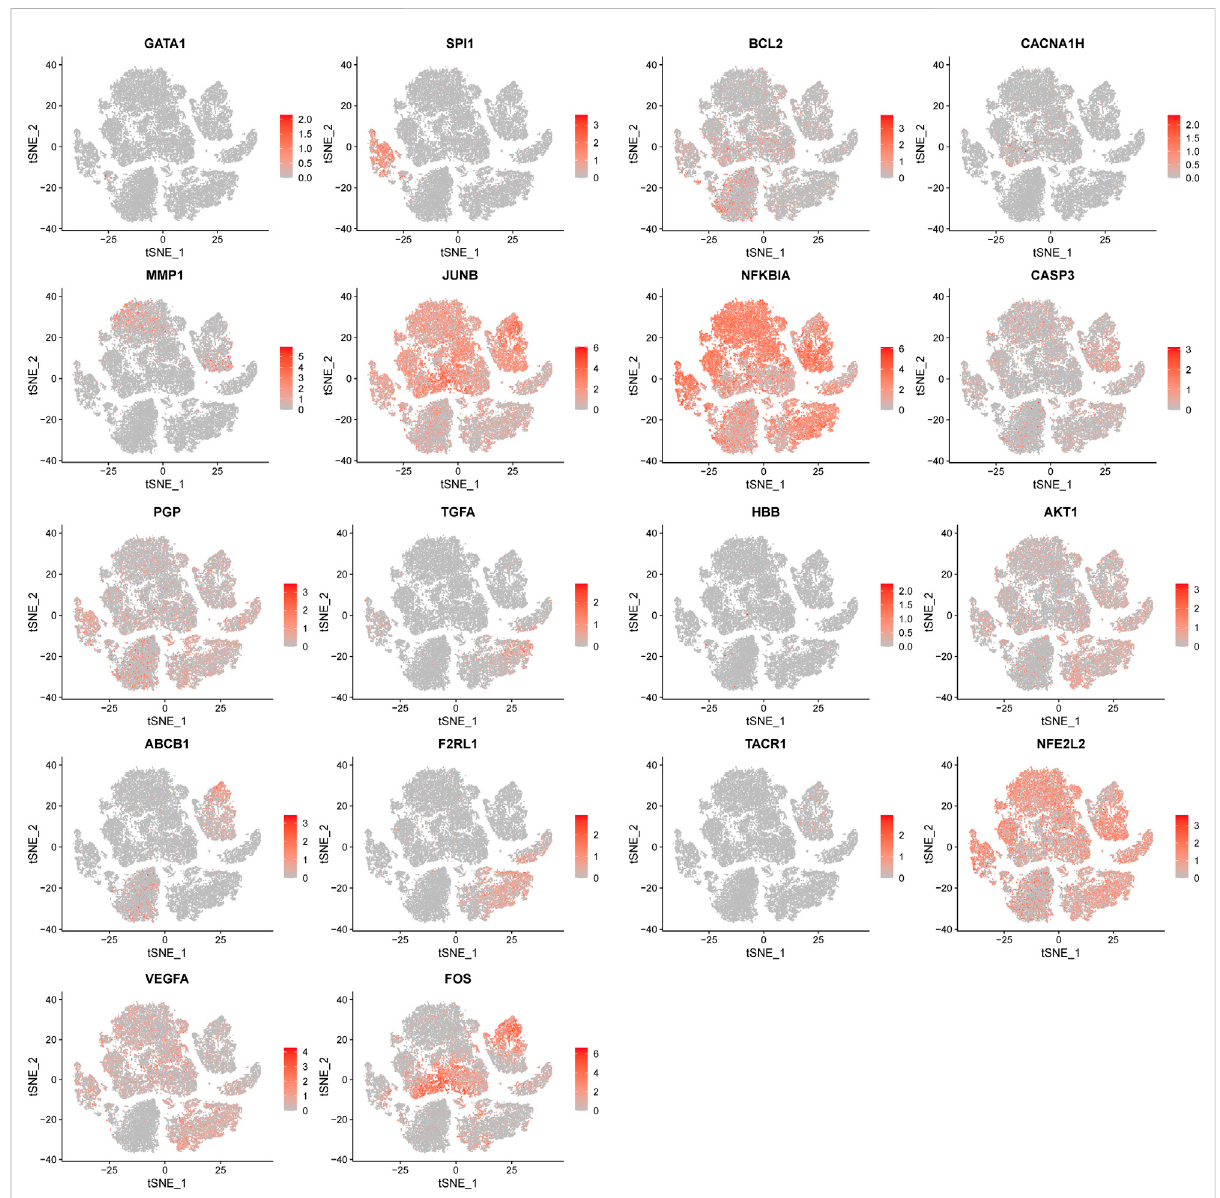
FIGURE 8 Distribution of t-SNE expression of DR-DEGs in single cell sequencing